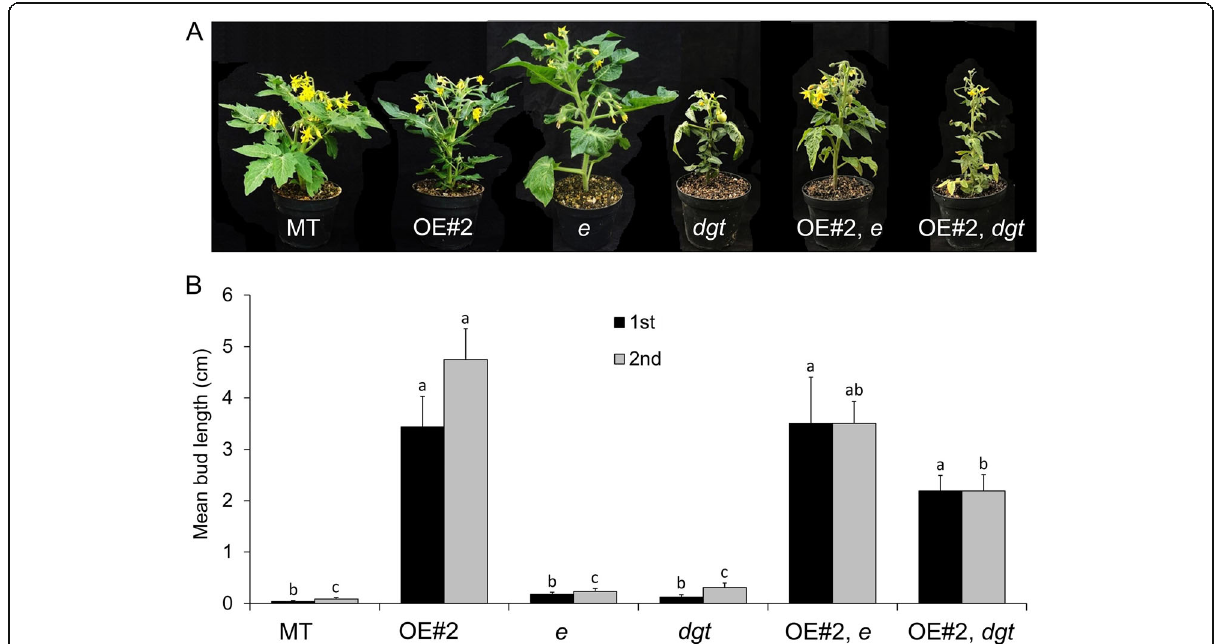
Fig. 5 Altered auxin status affects shoot branching in CKX2 -overexpressing tomato plants. A. Shoot phenotype of MT, CKX2-OE#2 (abbreviated as OE#2), entire ( e ), diageotropica ( dgt ) and the double transgenic-mutant CKX2-OE#2, e and CKX2-OE#2, dgt plants. B . Mean bud length of the first (1st) and second (2nd) axillary bud formed in the bottom at anthesis. Data are means ± SE . Letters indicate significant differences between genotypes (Tukey test; P <